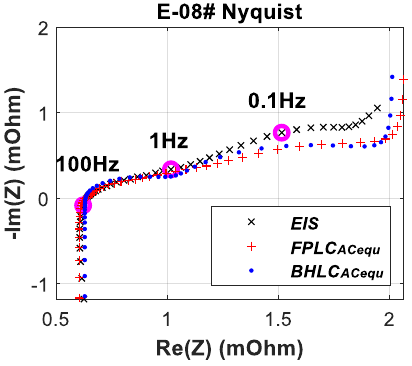
Figure 12. Experiment Nyquist curve is fitted by FPLC ACequ and BHLC ACequ .